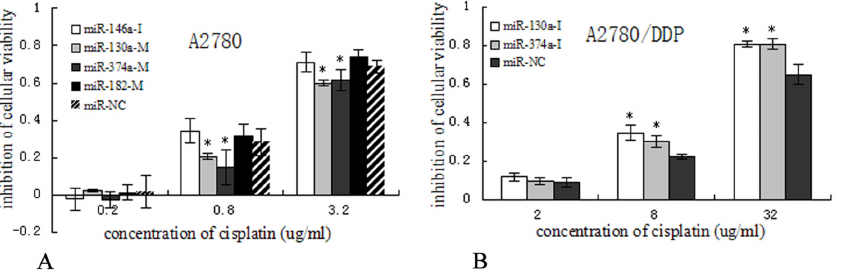
Fig 2. Cells inhibition by cisplatin following pre-treatment with miR-130a, -374a mimics or inhibitors. (A) The A2780 cells after transfection with miR-130a-mimic and miR-374a-mimic showed a increased ratio of surviving cells under the treatment of 0.8, 3.2 ug/ml cispaltin ( * p < 0.05). (B) miR-130a-inhibitor and miR-374a- inhibitor decreased the ratio of surviving cells under the treatment of 8, 32 ug/ml cispaltin ( * p < 0.05).